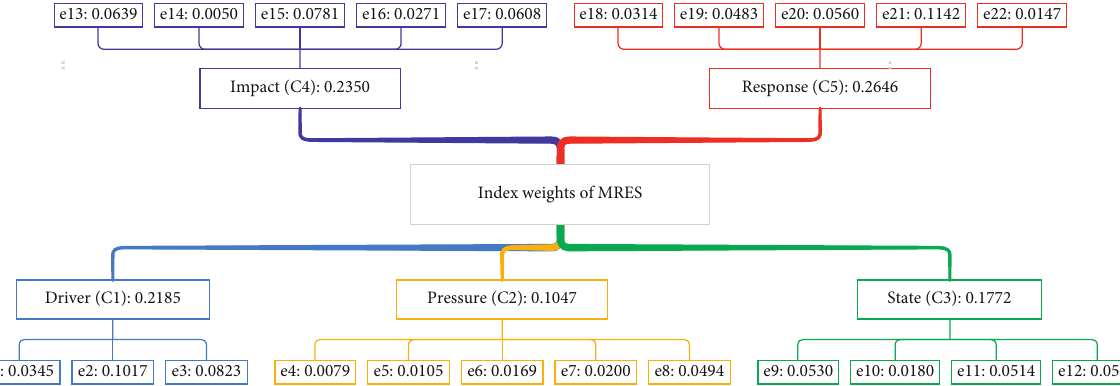
Figure 4: Index weights of MRES.